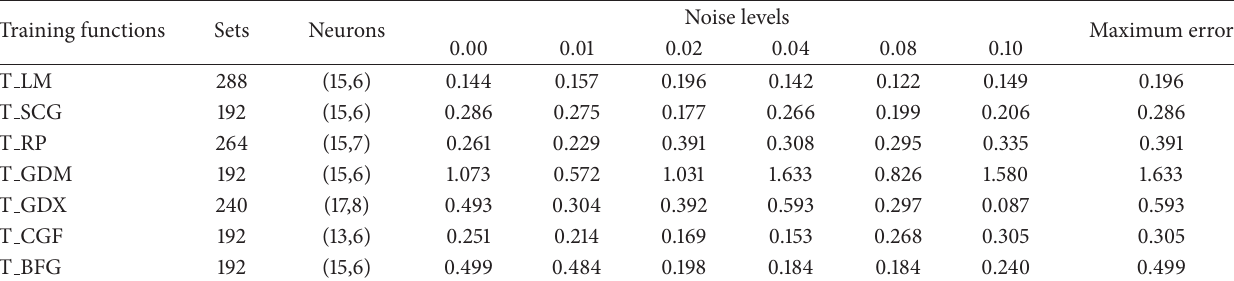
Table 16: The choice of the best neural network based on the strain damage parameters. Training functions